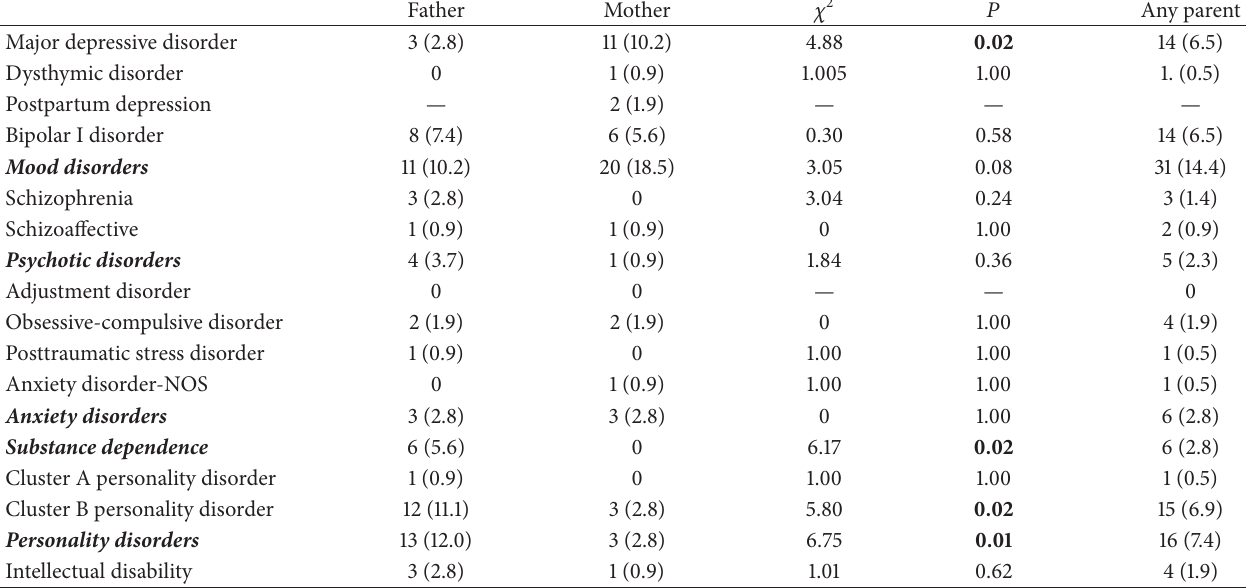
Table 1: Prevalence of psychiatric disorders among parents of a child with BID and the comparison between mothers and